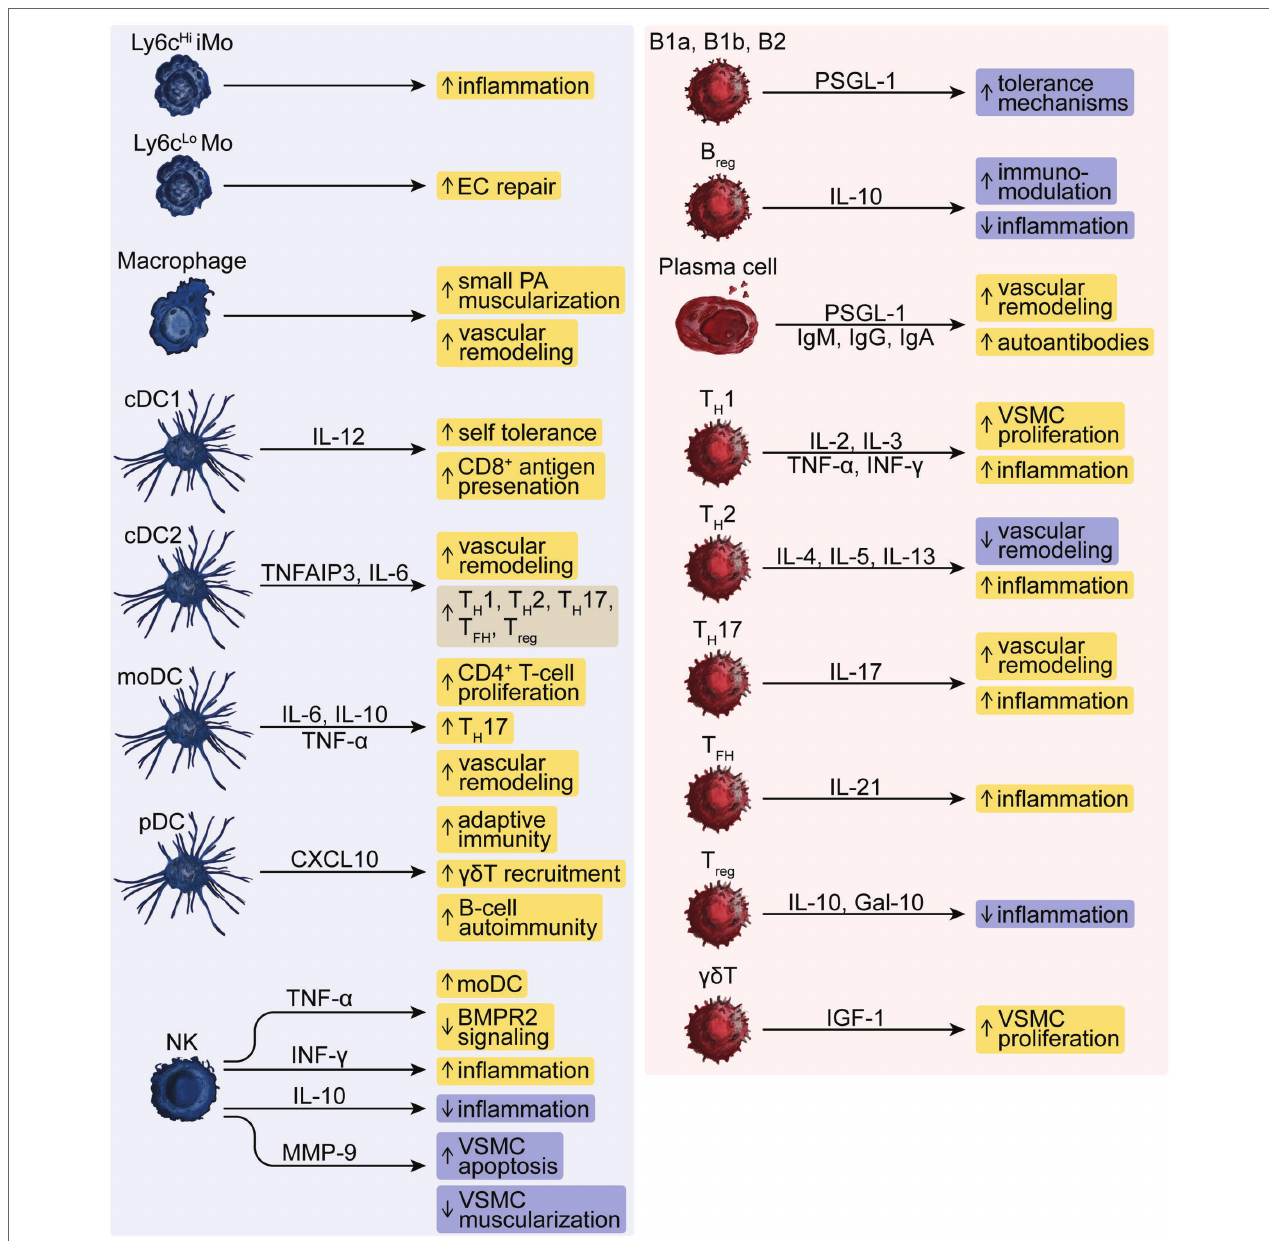
FIGURE 1 | The dysregulated function of innate and adaptive immune cells in PH. The innate effector cells represented by Ly6c Hi inflammatory monocytes (iMo) and Ly6c Lo monocytes (Mo), macrophages, conventional type-1 or type-2 dendritic cells (cDC1 or cDC2), monocyte-derived DCs (moDC), plasmacytoid DCs (pDC) and natural killer (NK) cells drive, e.g., inflammation, vascular remodeling and autoimmunity and modulate responses by B-lymphoid cells such as innate-like B1a and B1b, conventional B2 and regulatory B-cells (B reg ), T-helper (T H )-1, − 2, − 17 cells, T follicular helper (T FH ) cells, regulatory T (T reg ) -cells and γ δ T-cells that can further aggravate these responses in PH. Pro- and anti-inflammatory mediators comprise interleukins (IL), TNF- α , IFN- γ , CXC chemokines, matrix metallopeptidase (MMP)-9, Galectin (Gal)-10, and insulin-like growth factor (IGF)-1 as well as autoreactive immunoglobulins (Ig)-M, − G, and -A, and P-selectin glycoprotein ligand